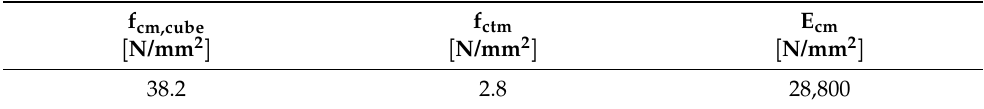
Figure 4. Strain results from 0 to 100 kN of the FOS. Due to the continuous measurement, the colors are referring to the load of the corresponding strain measurement. Table 1. Material properties of the